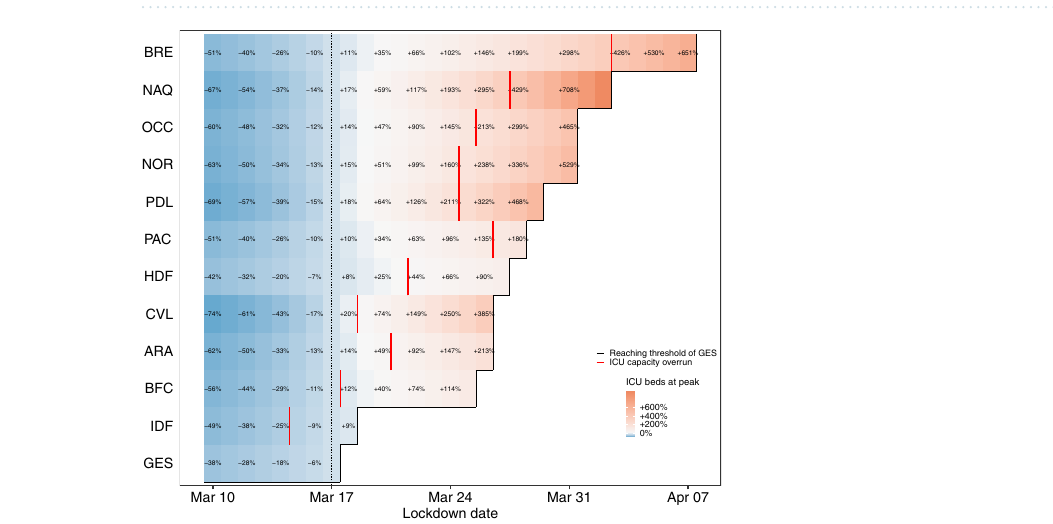
Figure 2. Relative change in the number of occupied ICU beds at the peak for each French metropolitan region (in %) according to lockdown date compared to the observed national lockdown. ICU intensive care unit, GES Grand-Est, IDF Ile-de-France, BFC Bourgogne-Franche-Comté, ARA Auvergne-Rhône-Alpes, CVL Centre-Val de Loire, HDF Hauts de France, PAC Provence-Alpes-Côte d’Azur, PDL Pays de la Loire, NOR Normandie, OCC Occitanie, NAQ Nouvelle-Aquitaine, BRE